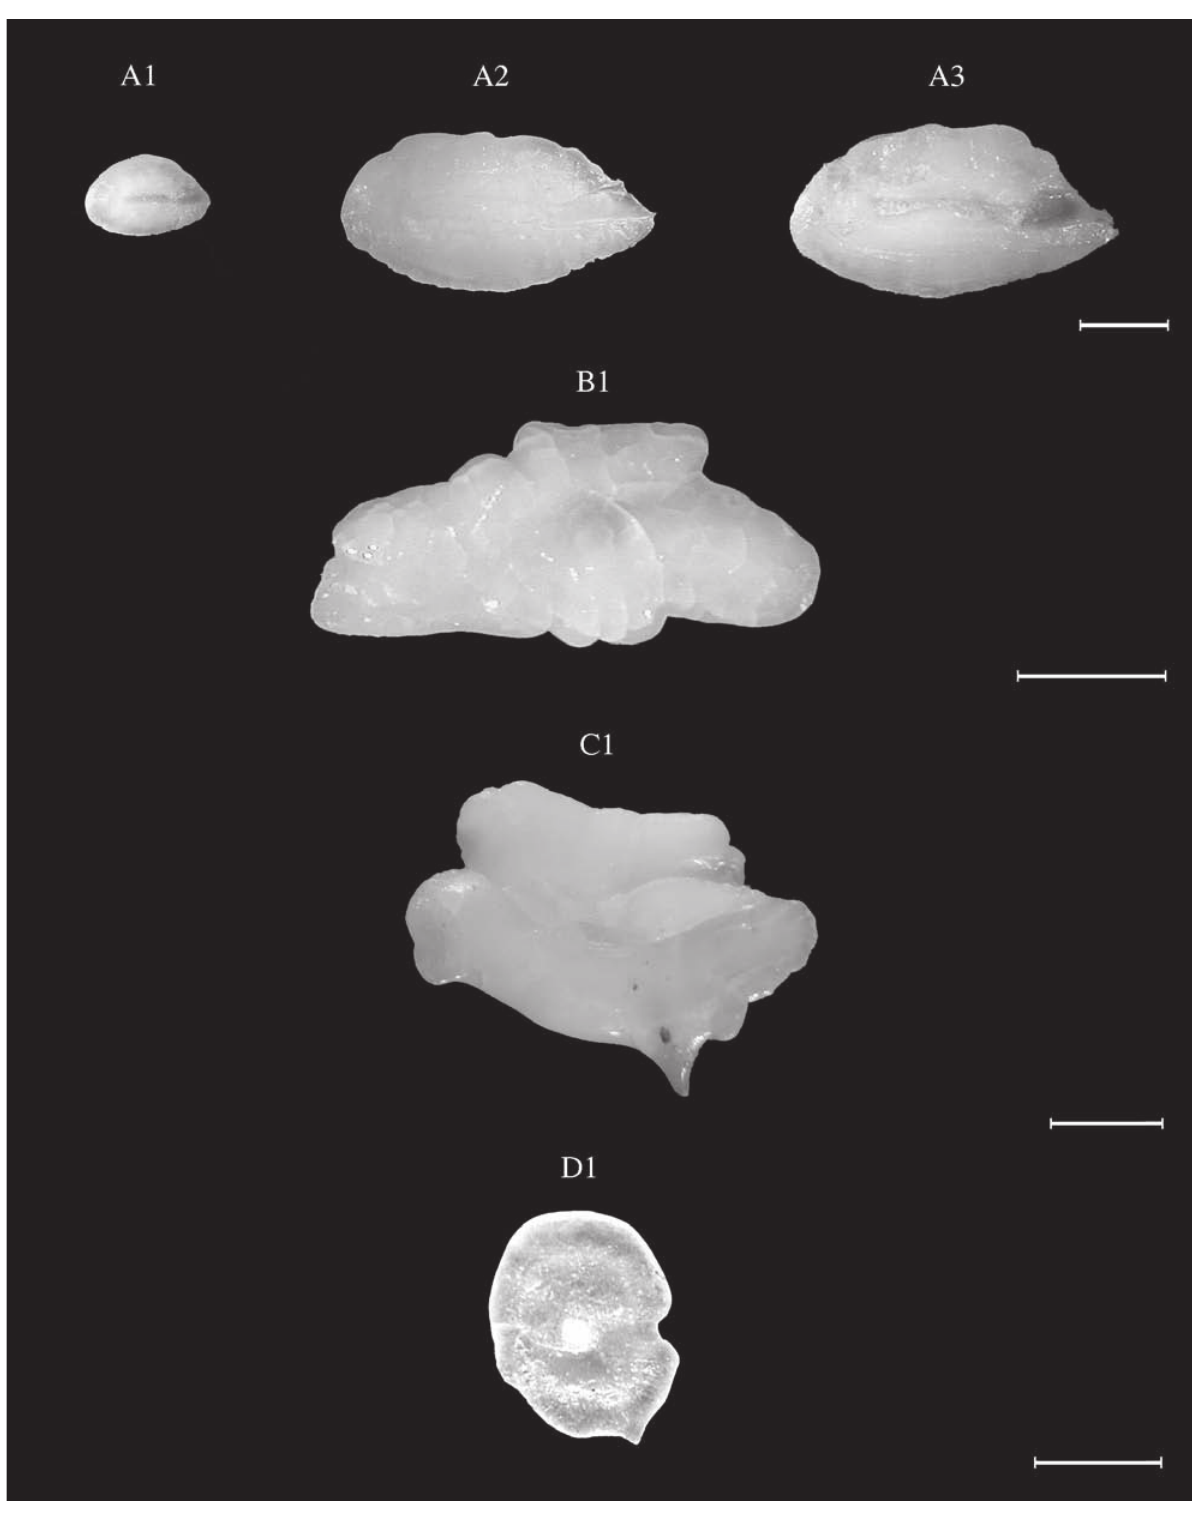
Fig. 21. – Bathypterois mediterraneus (WM). TL: A1, 6.0 cm; A2, 14.0 cm; A3, 17.0 cm Arctozenus risso (WM). TL: B1, 17.0 cm. Sudis hyalina (CEA). CL: C1, 3.7 cm. Benthosema glaciale (WM). TL: D1, 6.0 cm. Scale bar = 1